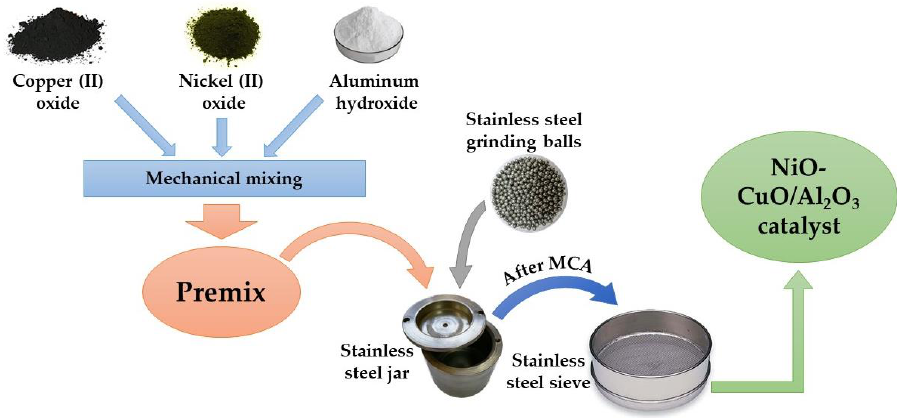
Figure 1. Schematic diagram of the catalyst preparation